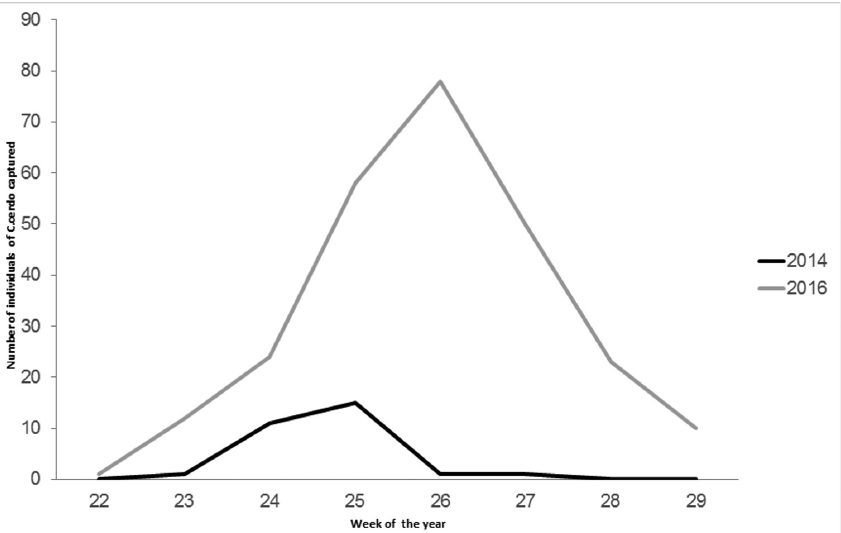
Figure 8. Phenology of Cerambyx cerdo during the sampling season of 2014 and 2016 at Bosco della Fontana.